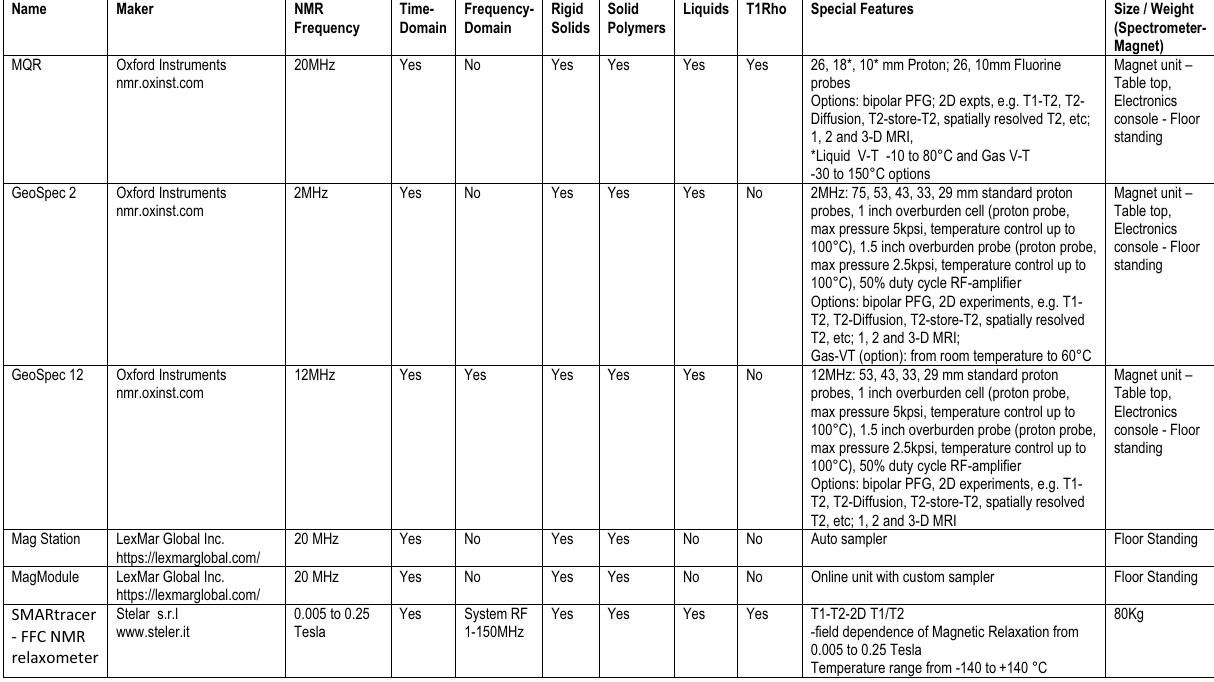
Magnet unit – Table top, Electronics console -Floor standing